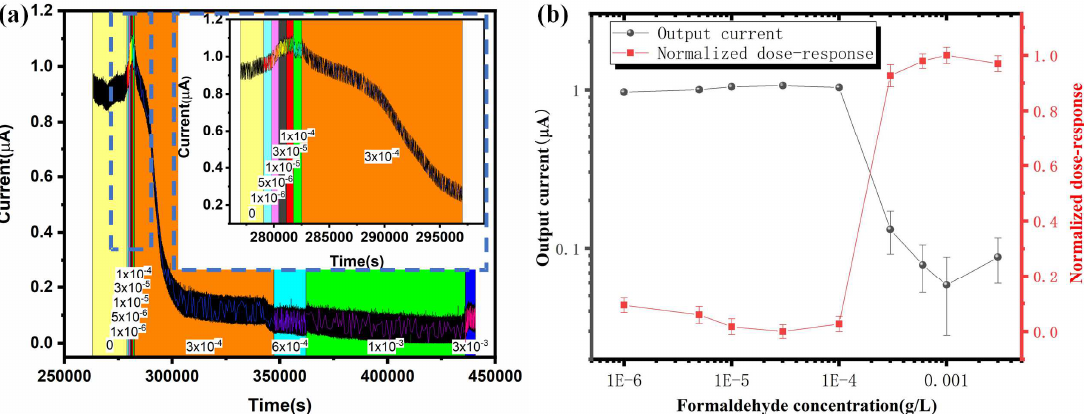
Figure 4. ( a ): Real-time output current versus time for the microscale MFC biosensor after different concentrations of formaldehyde between 1 × 10 −6 g/L to 3 × 10 −3 g/L is spiked into the anolyte; inset: zoomed in view of the dashed rectangle; ( b ): Left: output current versus formaldehyde concentration for the microscale MFC biosensor; right: normalized dose–response versus formaldehyde concentration; a sigmoid relationship of dose–response curve is observed for the first time in MFC biosensors, in agreement with traditional toxicology dose–response curve.